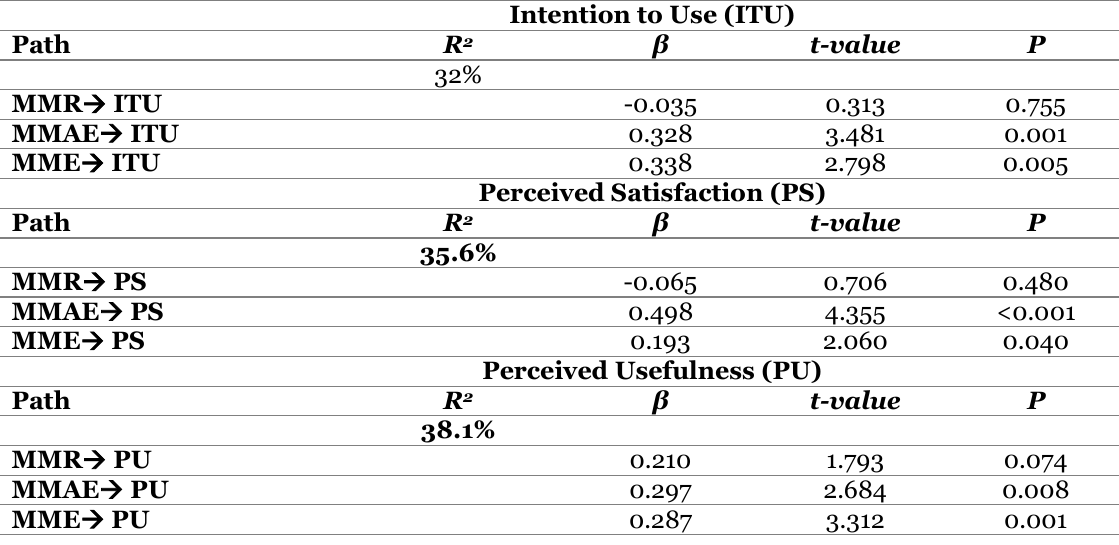
Intention to Use